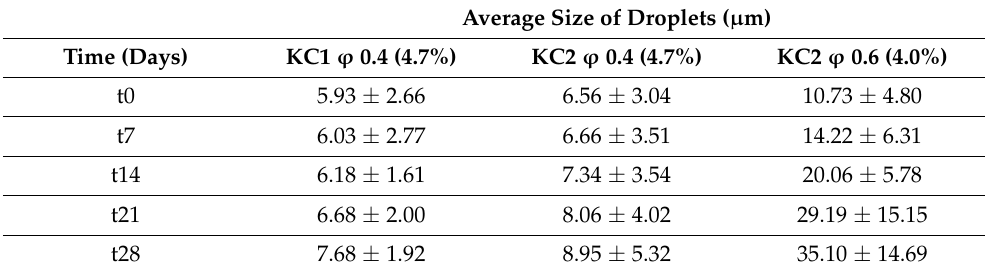
Table 3. Droplet size of the produced Pickering emulsions (KC1 ϕ 0.4 (4.7%), KC2 ϕ 0.4 (4.7%),